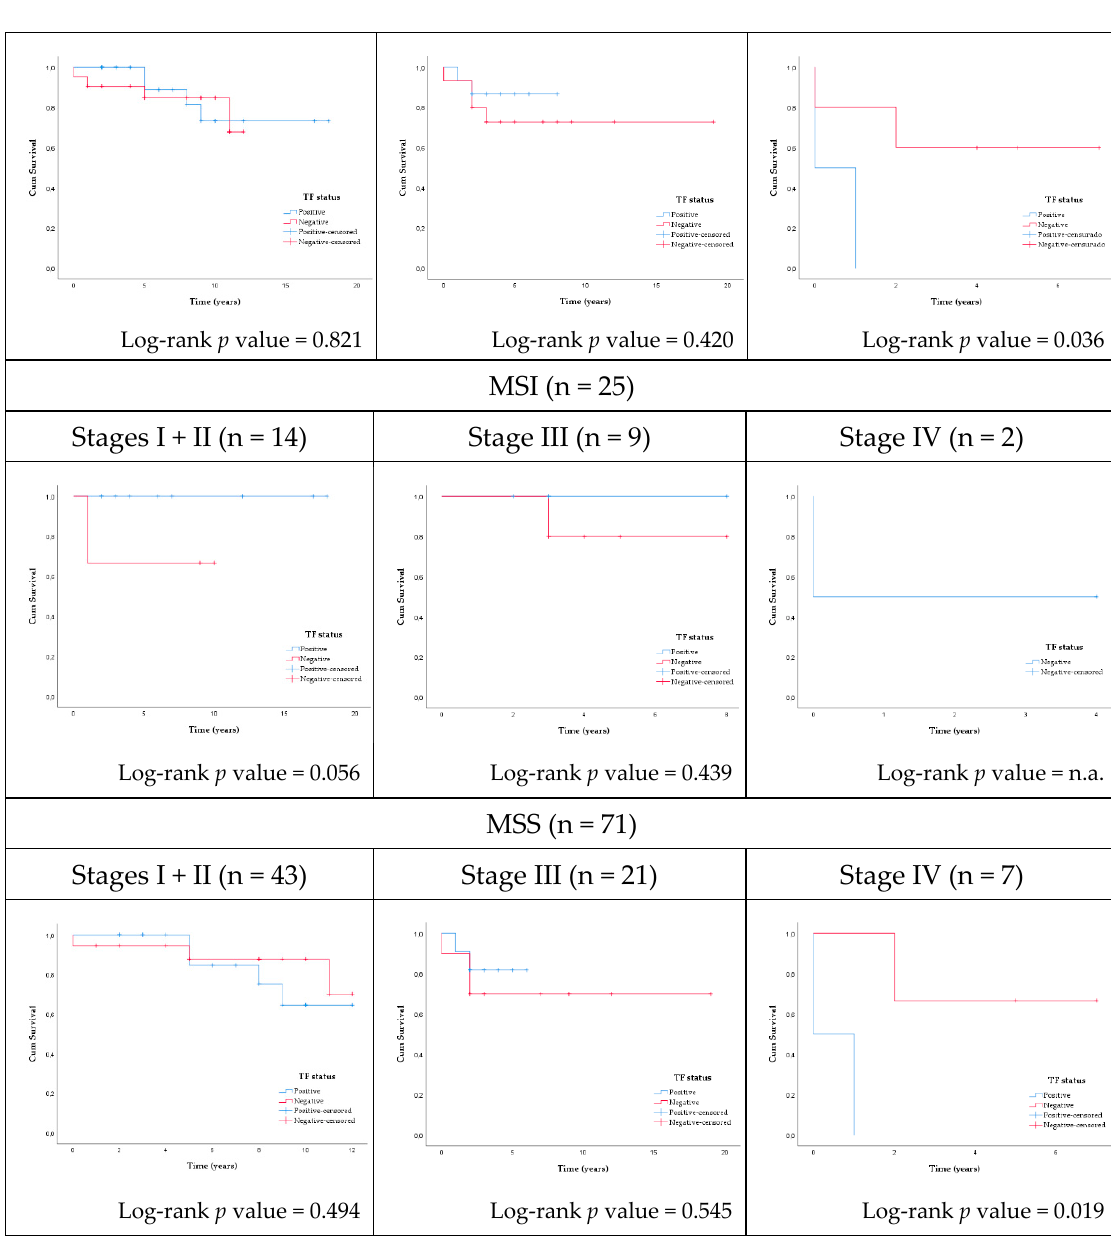
Figure 2. Kaplan–Meier curves of the overall survival of the patients according to TF expression in the tumors.